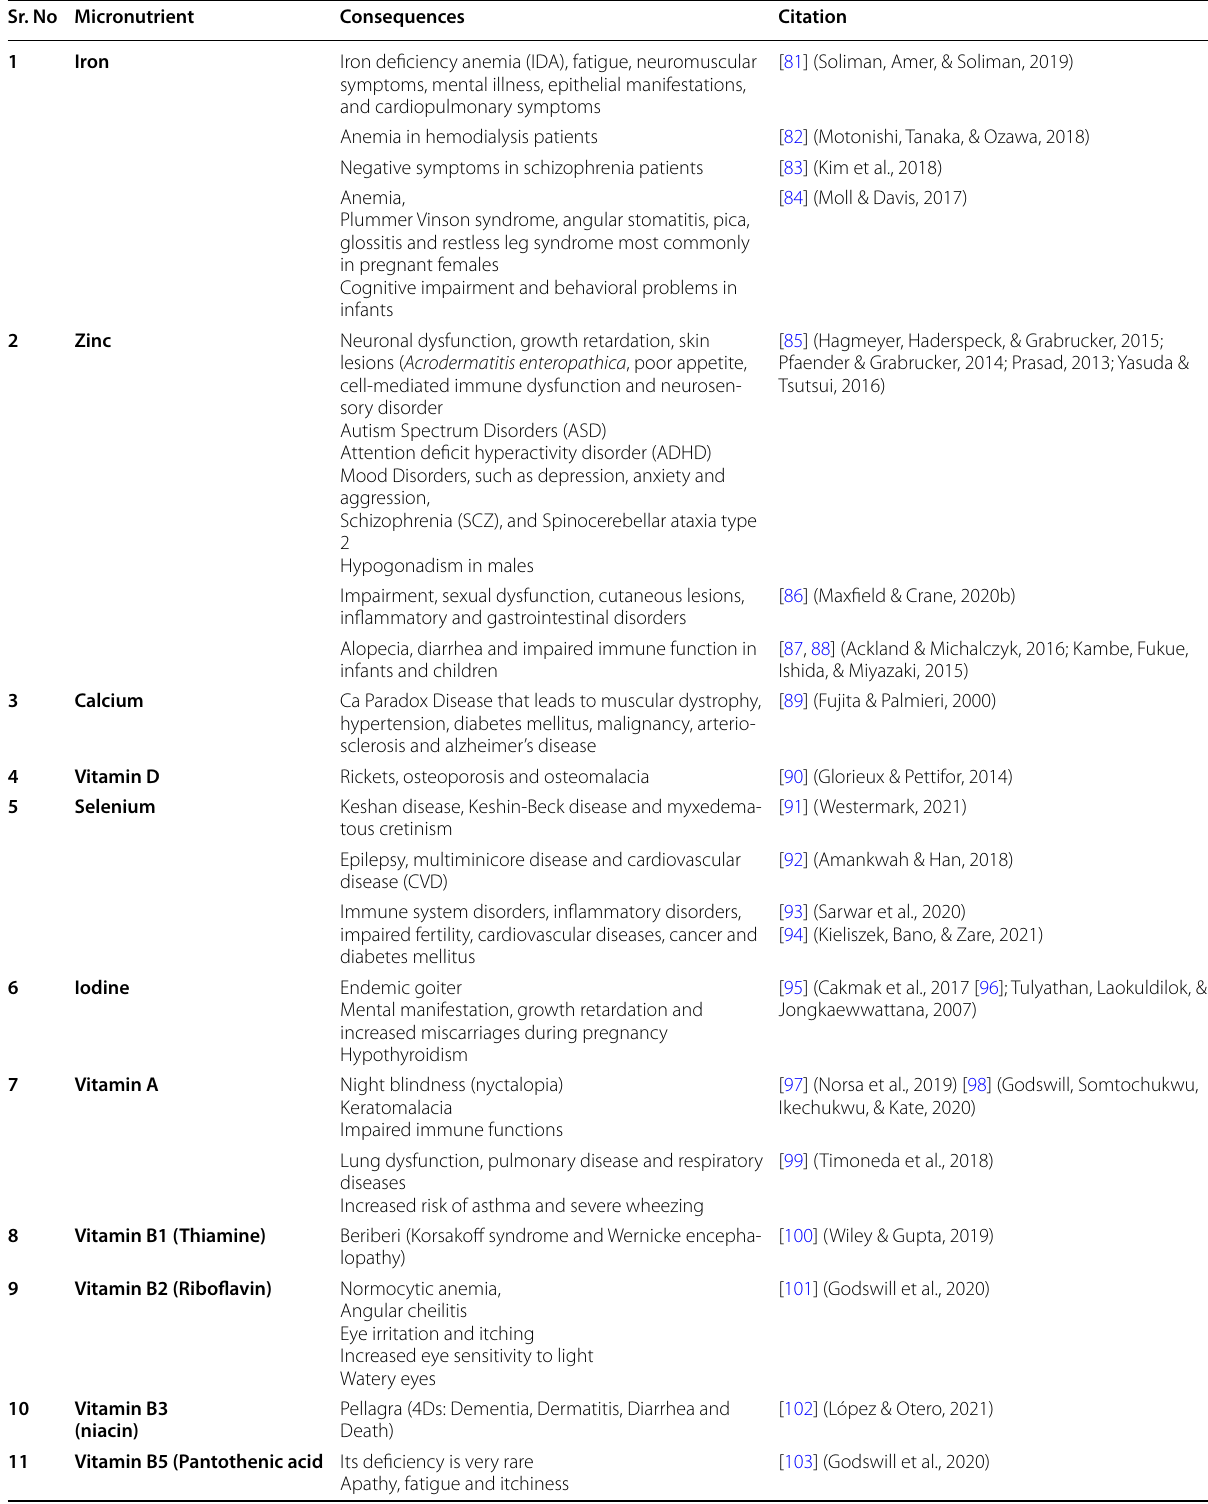
Table 2 Mineral & Vitamin Deficiency Consequences Sr. No